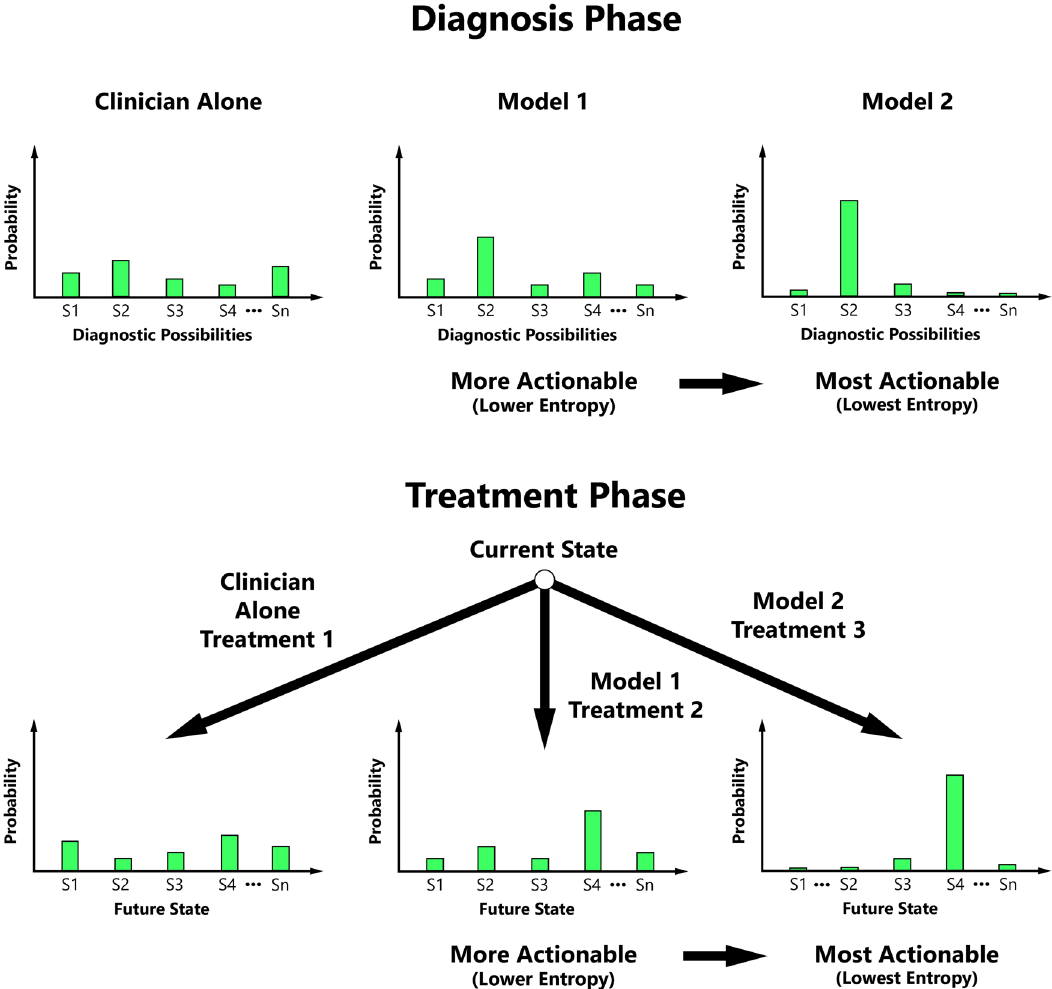
Fig. 1 A conceptual schematic illustrating the typical relationship between machine learning actionability and entropy. Actionability typically increases with decreasing entropy of the diagnostic possibility probability distribution and/or conditional future state probability distribution during key phases of medical decision-making. S1 State 1, S2 State 2, S3 State 3, S4 State 4, Sn the Nth